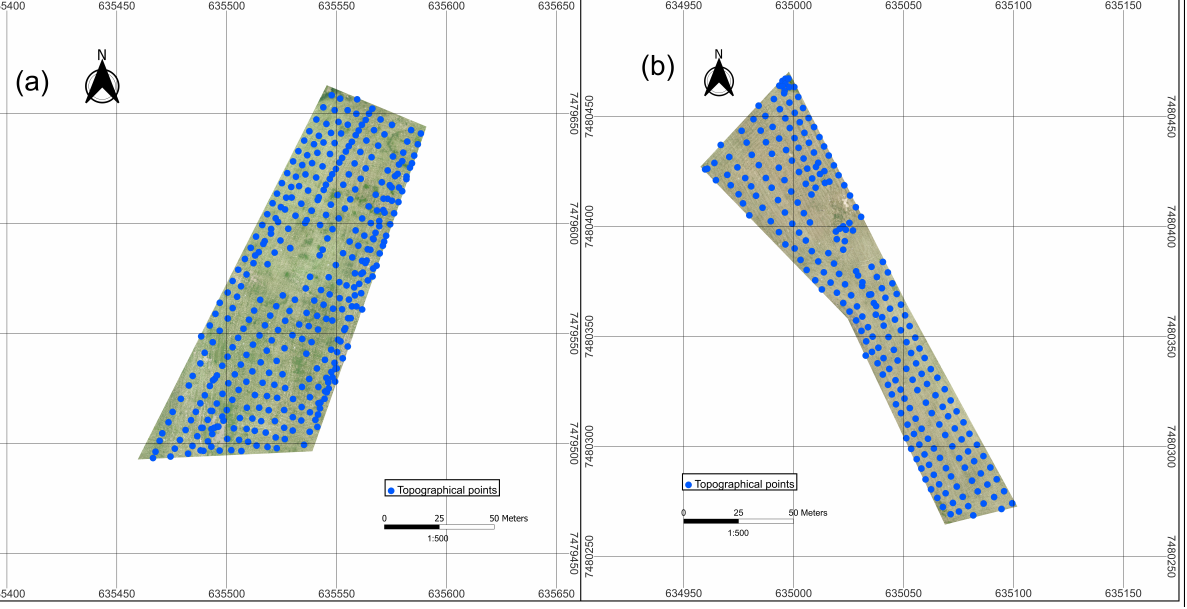
Figure 5. Surveyed points from the areas of Serop é dica municipality: ( a ) location of points registered in area 3 by conventional topographic survey and ( b ) location of points registered in area 4 by the conventional topographic survey.